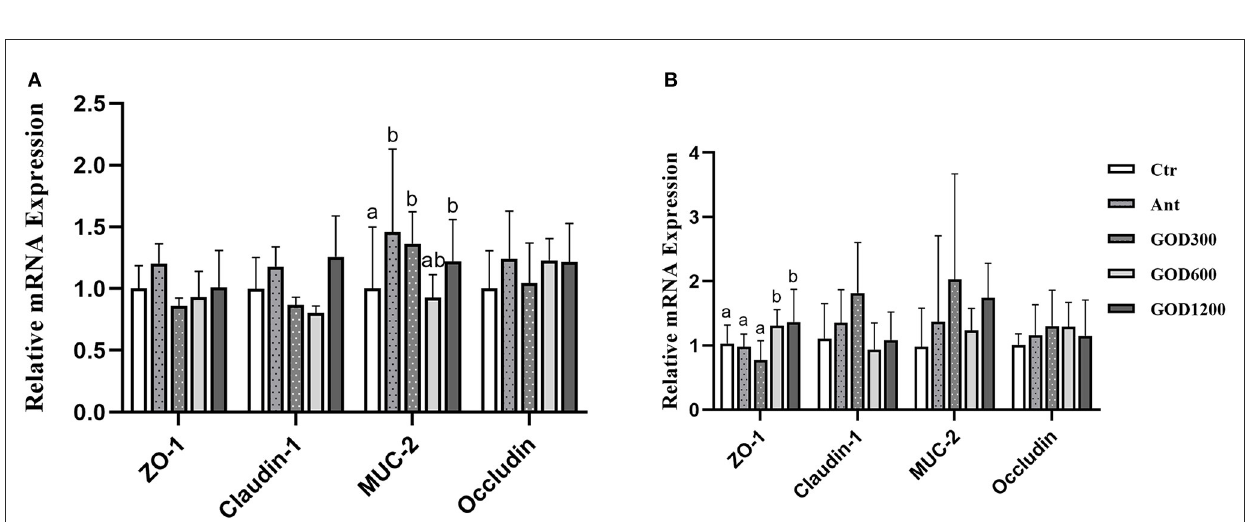
FIGURE2 The effect of GOD-supplemented dietary on the relative mRNA expression of jejunal junction protein genes and the mucin gene of broilers during both days 0–21 (A) and 22–42 (B) growth phases. a,b Means within a row with no common superscripts are significantly different ( n = 6, P < 0.05). Ctr, negative control fed with the basal diets; Ant, positive control fed with the basal diets added 50 mg/kg aureomycin; GOD300, GOD600, and GOD1200, the basal diets supplied with 300, 600, and 1,200 U/kg glucose oxidase, respectively. a,b Means within a row with no common superscripts are significantly different ( P < 0.05). Ctr, negative control group fed with the basal diets; Ant, positive control group fed with the basal diets added 50 mg/kg aureomycin.